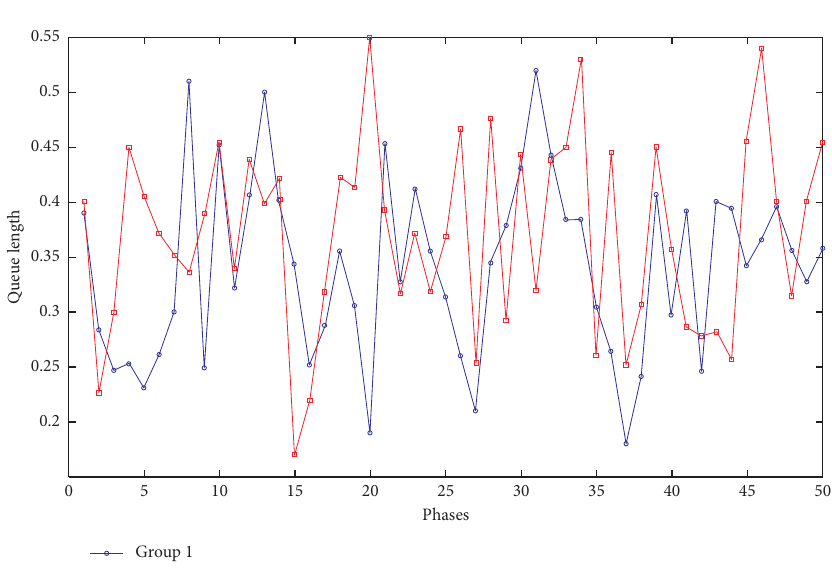
Figure 8: Variations in queue length at intersection 5 under low congestion levels.